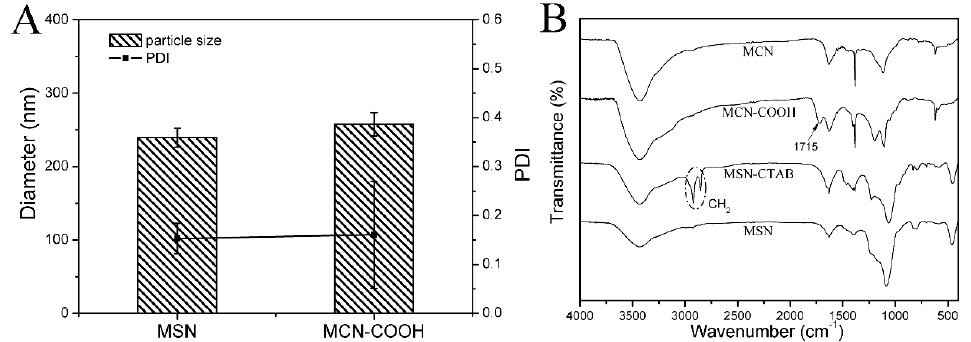
Figure 3. ( A ) The corresponding zeta potentials and particle sizes of MCN–COOH and MSN; ( B ) the Fourier transform–infrared (FT–IR) spectra of MCN, MCN–COOH and